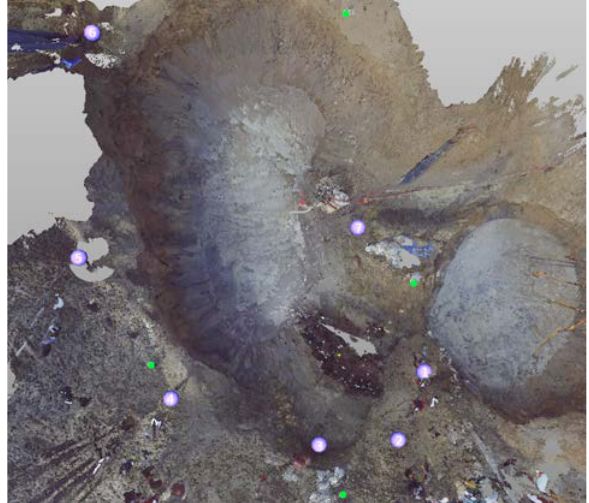
Figure 11. Laser scanner and targets positions